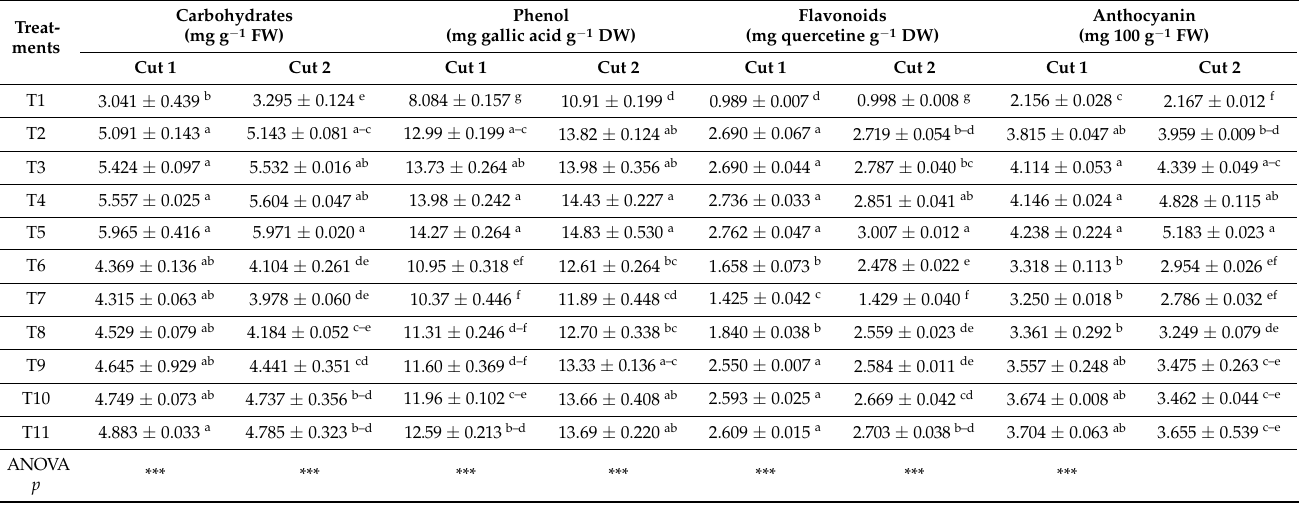
Table 8. Effect of iron (nano, sulfate, and chelated) foliar spray on carbohydrates and phytopharma- ceuticals of Rose Scented Geranium in the first and second cut during the second season. Means of three replicates are presented with ±